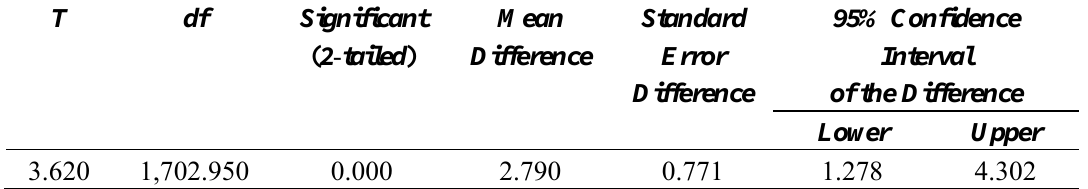
Table 4. T - test on retweeting of posts linking photos vs . videos